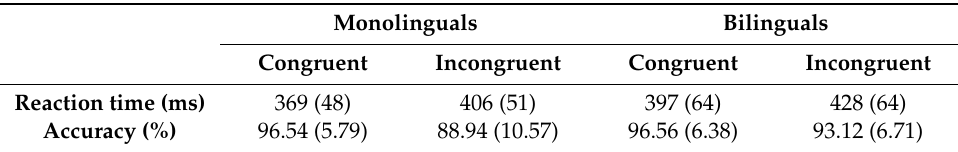
Table 6. Group means of Simon task performance (standard deviations in brackets).